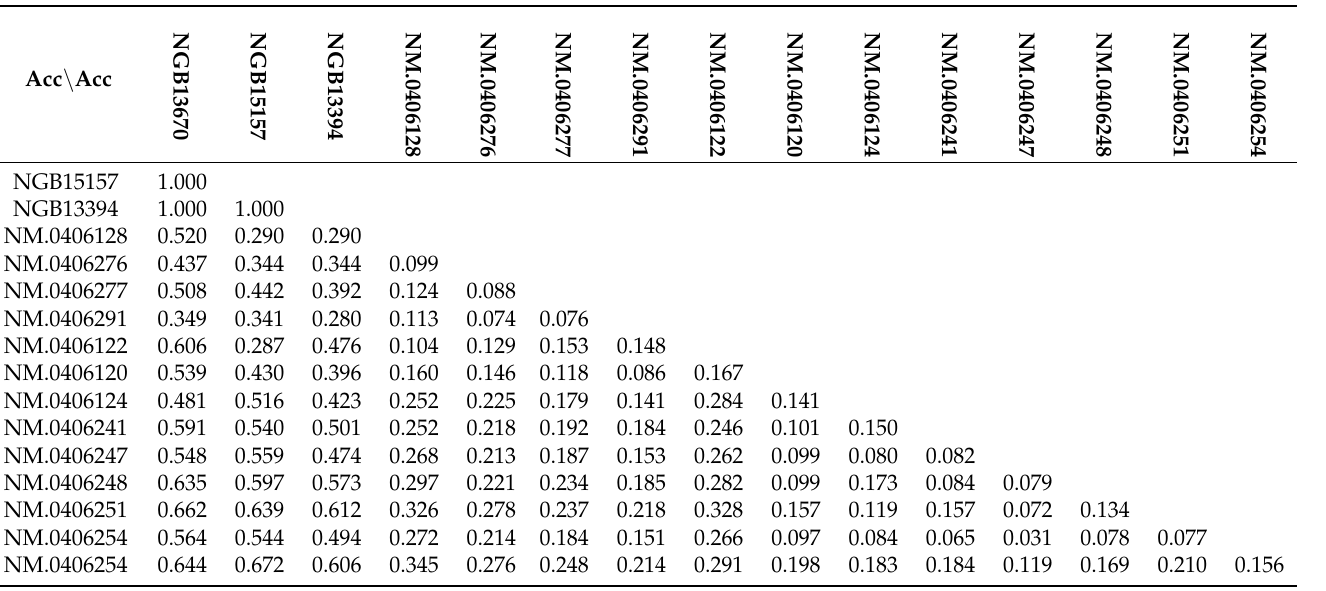
Table 3. Pairwise Fst values for all pairs of